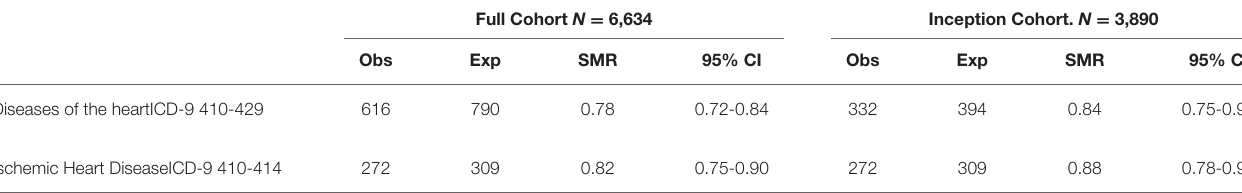
TABLE 2 | Cardiac mortality in US cohort.